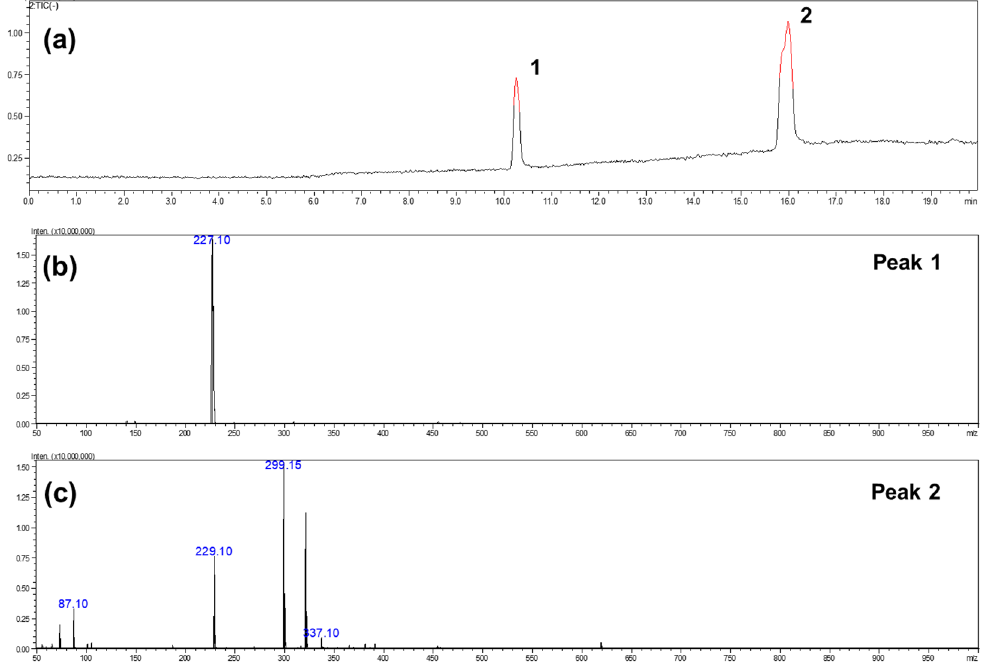
Figure 3. ( a ) LC chromatogram of resveratrol butyrate esters (RBE) as well as ( b , c ) mass spectra of peak 1 and peak 2. 1 − 2 peak of LC chromatogram.